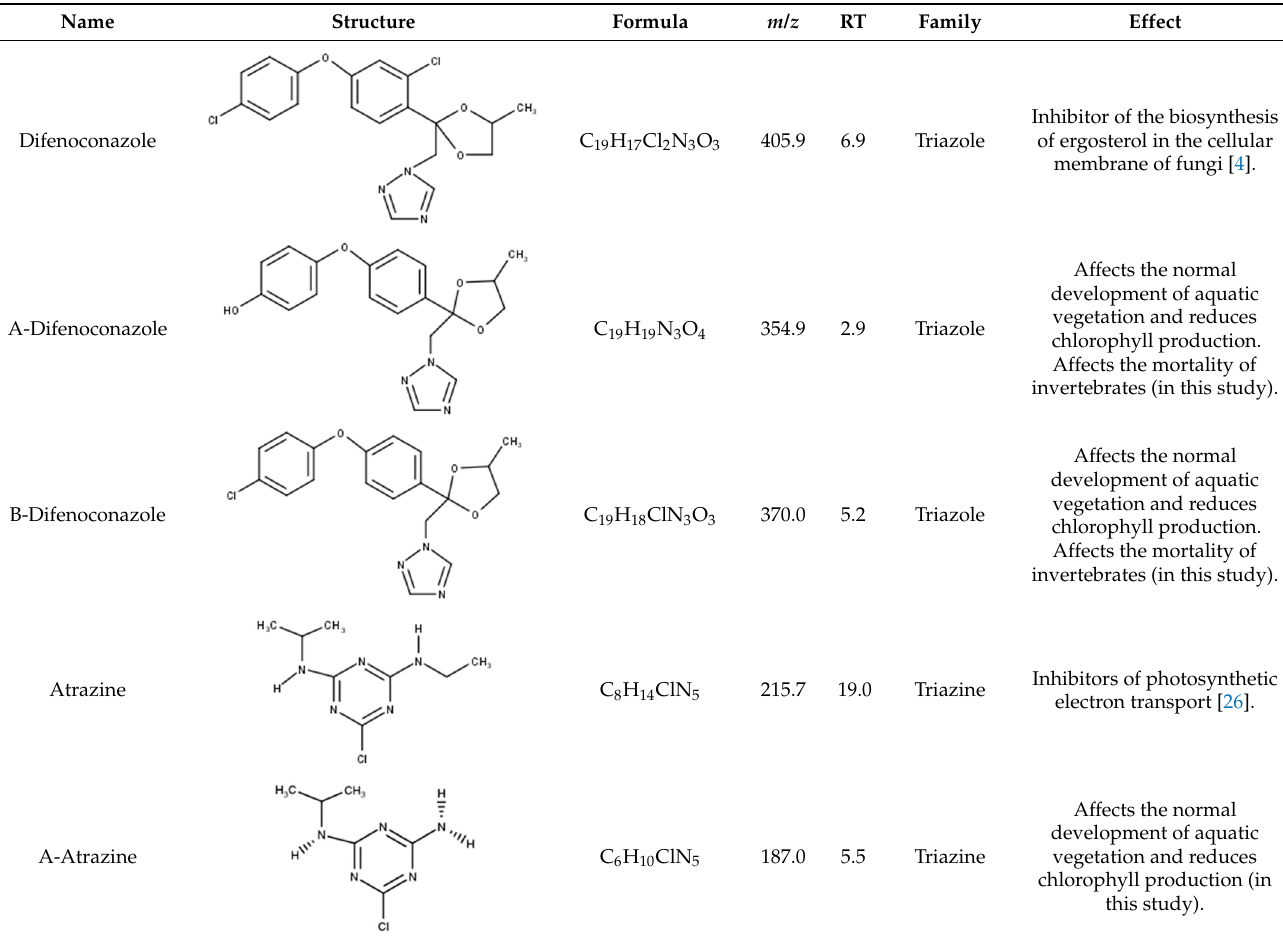
Table 1. Summary of the characteristics and effects of the studied pesticides as well as their photo- degradation products after UV irradiation. m/z refers to the observed mass/charge number ratio. RT indicates the retention time expressed in minutes. Structure